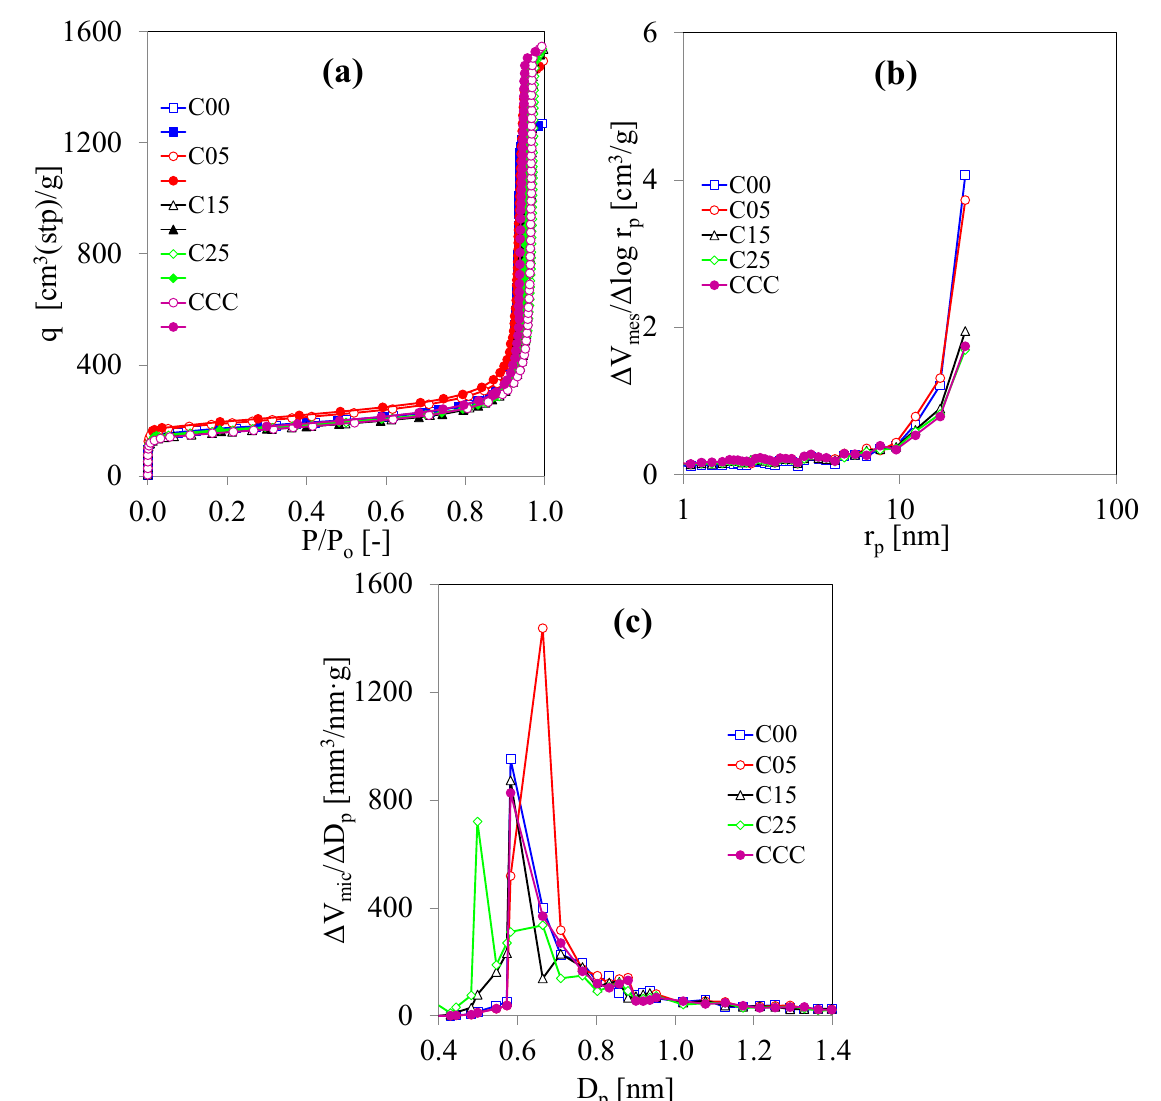
Figure 5. N 2 adsorption analysis of CaF and C/C composite xerogels prepared by using the CF/RF ratio for 0.00–0.25 g/g at R/C = 500 mol/mol and R/W = 0.25 g/cm 3 : ( a ) N 2 adsorption and desorption isotherms at − 196 °C (open symbols = adsorption; closed symbols = desorption), ( b ) mesopore size distribution, and ( c ) micropore size distribution.